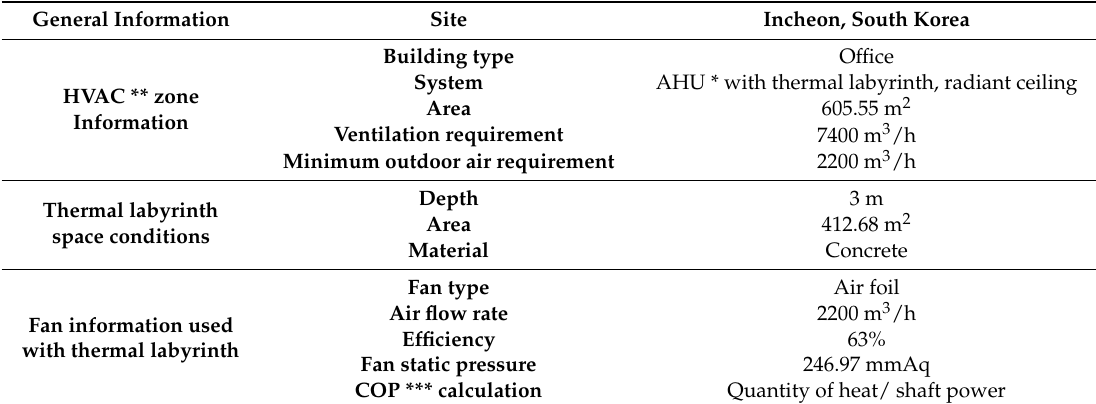
Figure 1. Photographs and plans of sample building. ( a ) Sample building; ( b ) Building Section; ( c ) Thermal Labyrinth; ( d ) Building basement plan. Table 1. Conditions of the studied building and thermal labyrinth system.